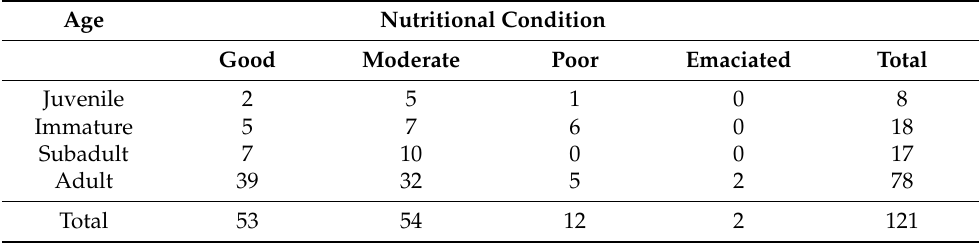
Table 2. Nutritional status of 121 Common Eiders in relation to their